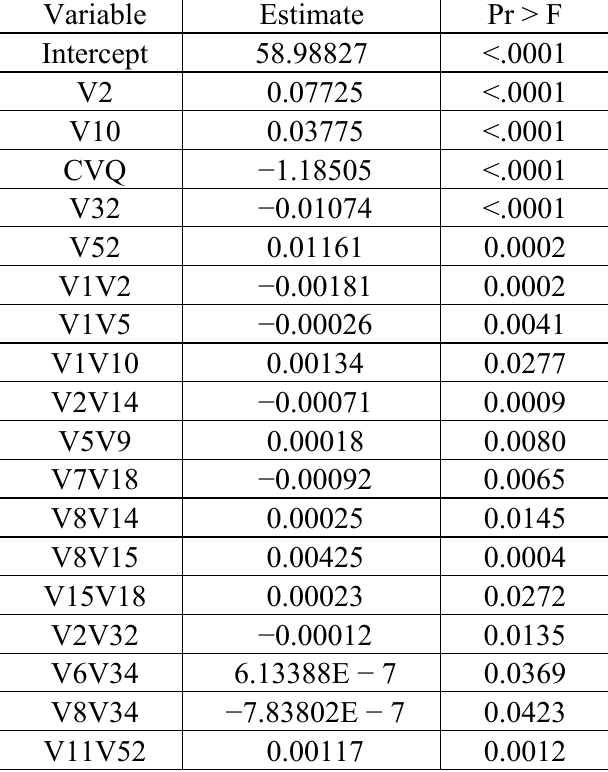
Table 1. Regression modeling